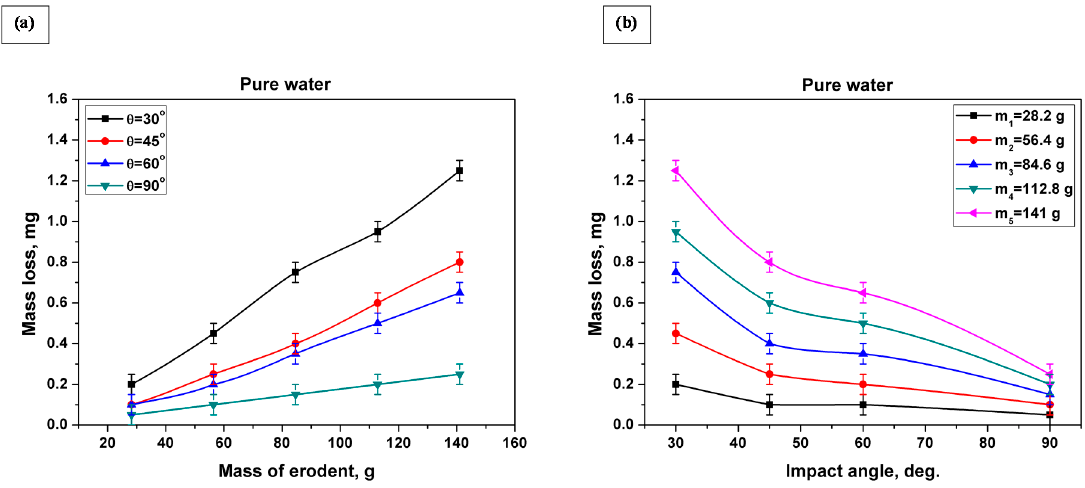
Figure 8. Mass loss of the SLMed Ti-6Al-4V alloy due to slurry erosion in pure water at impact angles 30°, 45°, 60°, and 90°: ( a ) mass loss versus mass of erodent; ( b ) mass loss versus impact angle.